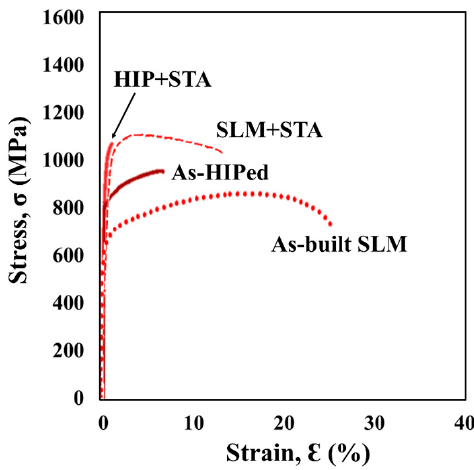
Figure 8. Engineering stress-strain curves of HIP specimen and SLM specimens at room temperature.